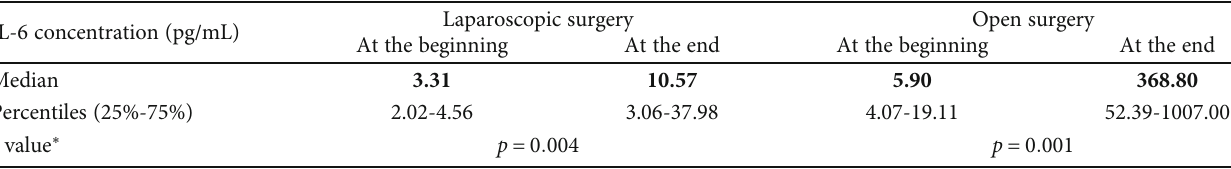
Table 2: IL-6 concentration in peritoneal lavage fl uid of children at the beginning and at the end of laparoscopic and open cholecystectomy. IL-6 concentration